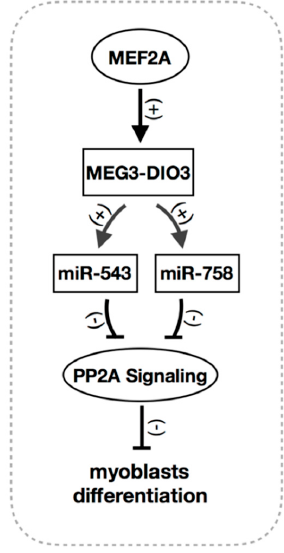
Figure 7. The potential roles of MEF2A-MEG3/DIO3-PP2A signaling regulatory axis in myoblast differentiation. That is, the MEG3-DIO3 miRNA cluster functions downstream of MEF2A to modulate PP2A signaling in myoblast differentiation. Black arrows and “(+)” represent positive regulation. T-bars and “(-)” represents negative regulation.